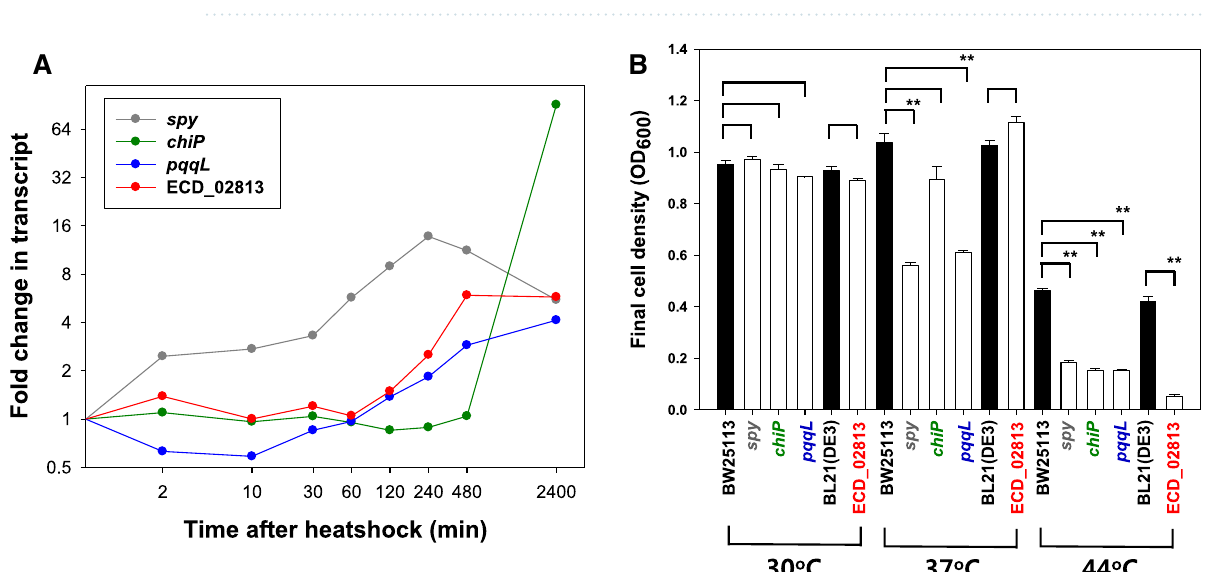
Figure 5. Effect of heatshock-responsive gene ( spy , chiP , pqqL , and ECD_02813) deletion on bacterial growth with temperature. ( A ) Temporal expression levels. The X-axis denotes the culture time after the temperature upshift (min in log scale). The Y axis denotes the log 2 -transformed transcript ratio in reference to the mRNA intensity 30 min before the temperature upshift. ( B ) Final cell densities of the deleted mutant strains (in white bars) and their background strains (black bar) grown in MR medium for 24 h at 30 °C, 37 °C, and 44 °C (** p < 0.01). The error bars represent the standard deviation of the mean from three independent